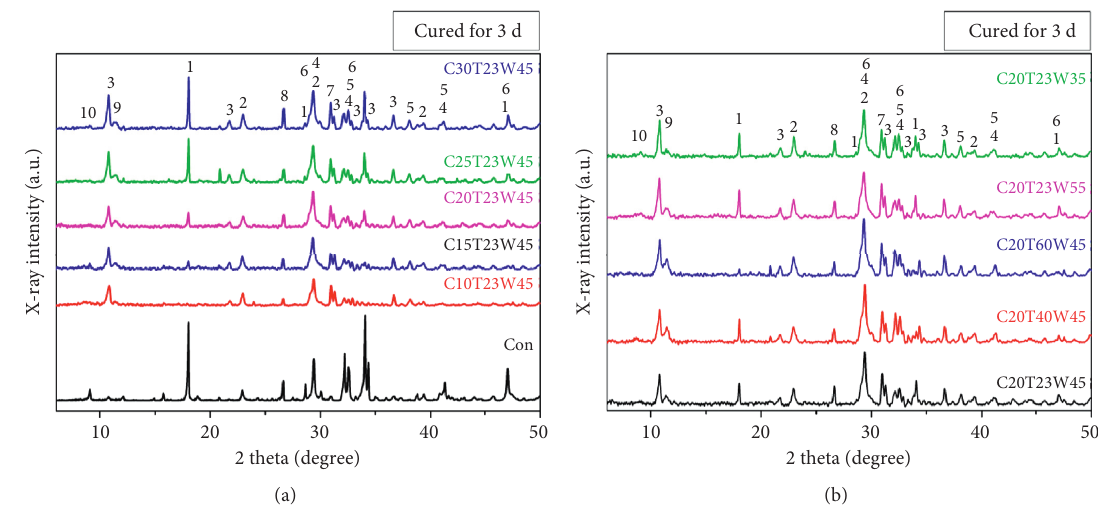
Figure 2: XRD patterns of 3d pastes ((1) CH, (2) calcite, (3) hydrocalumite, (4) C (9) hydrotalcite, and (10) AFt).